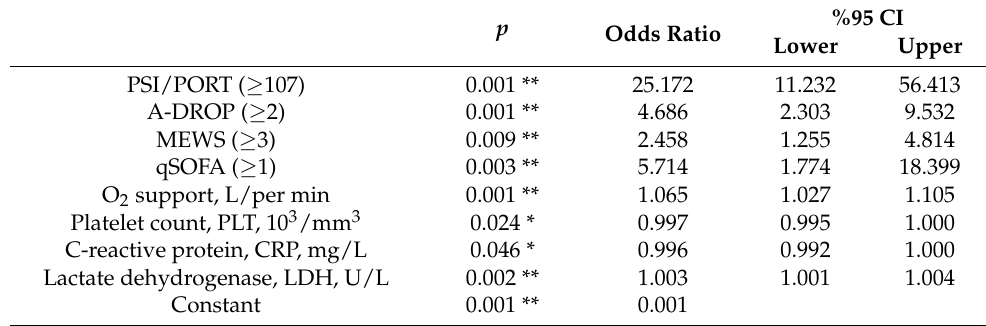
Table 6. Multivariate logistic regression analysis for risk factors on